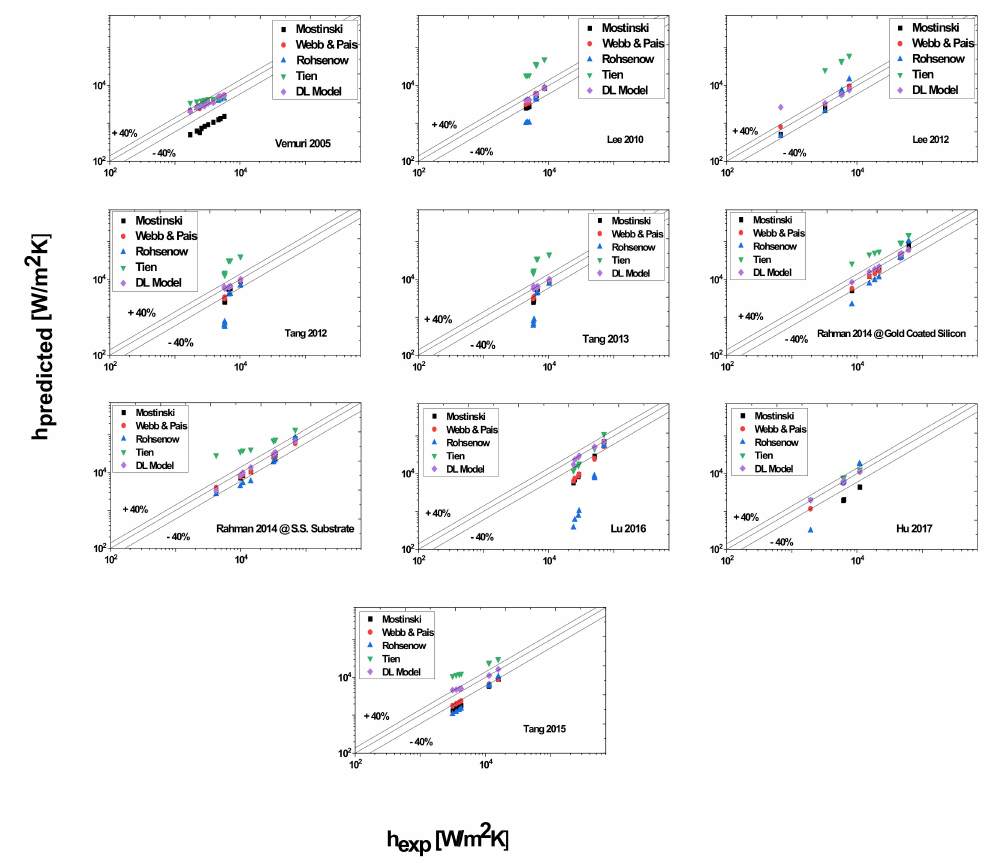
Figure 12. Predictions with correlations available in literature and DL